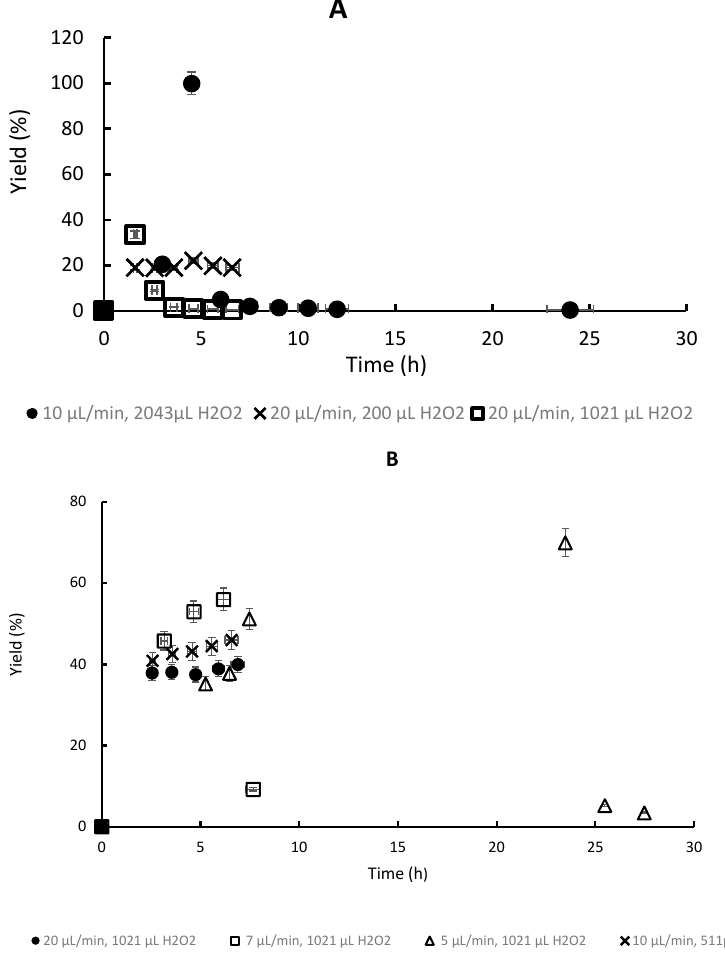
Figure 5. Chemoenzymatic synthesis of FDCA in a continuous packed-bed bioreactor catalyzed by Novozym 435 at a different flow rate. ( A ) 40 °C; ( B ) 30 °C. Reactions conditions: 50 mM of DFF, 500